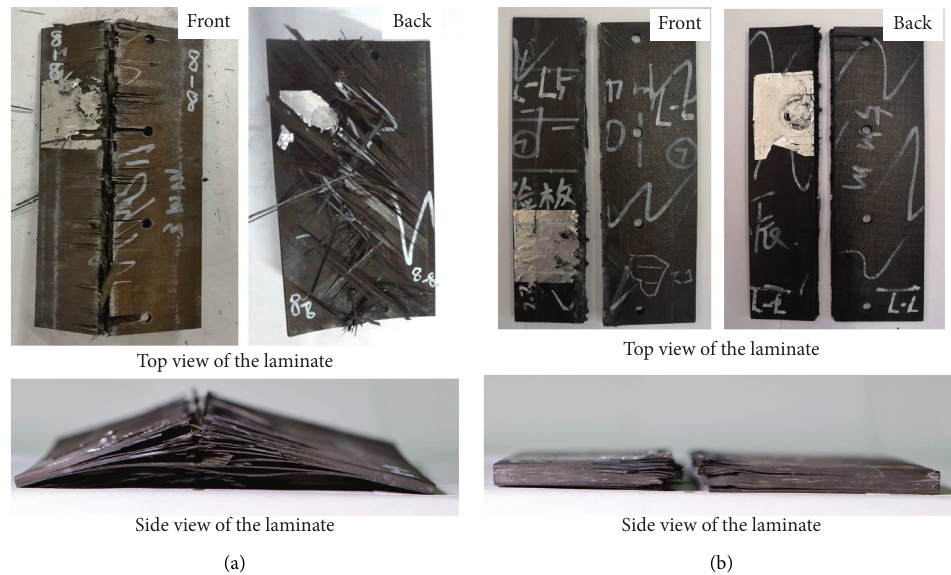
Figure 9: Cutting tests results of the laminate (a) without and (b) with weakening groove. Protective cover